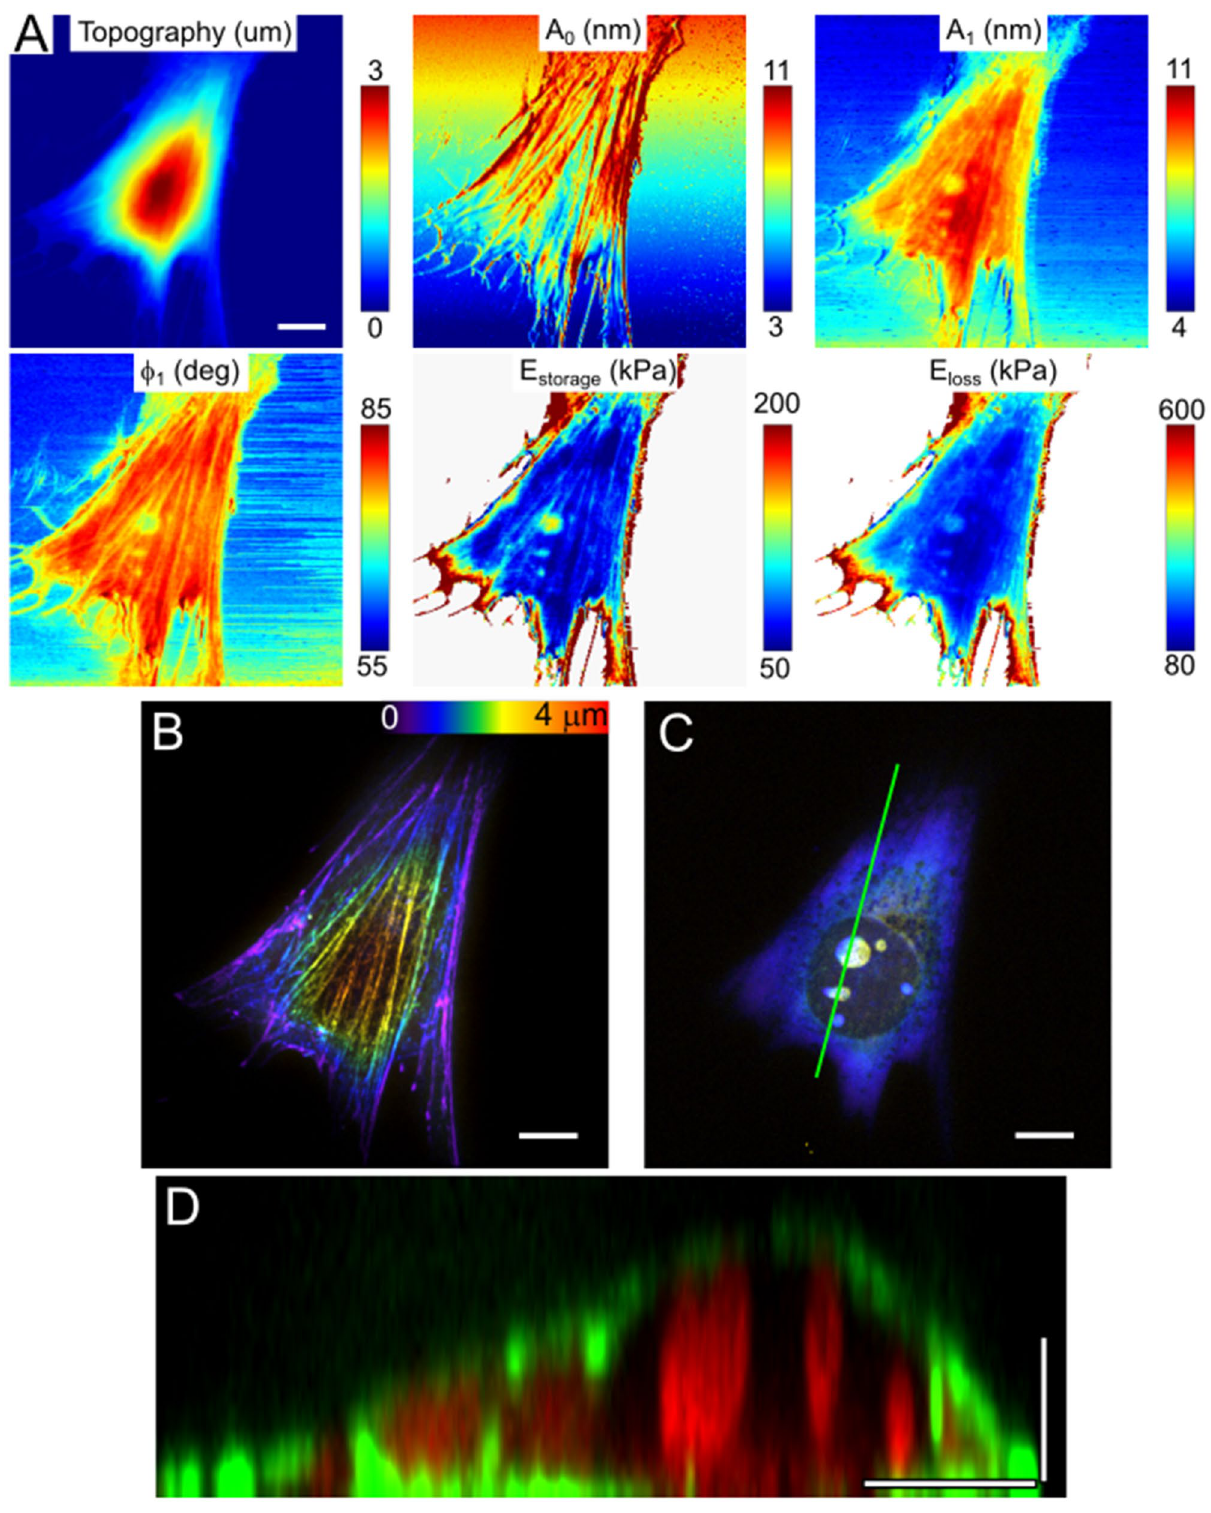
Figure 3. The NIH 3T3 fibroblast, AFM observables and nanomechanical maps. ( A ) and SDCM color-coded height images ( B , C ). Both perinuclear actin cap fibers and nucleoli could be detected in the amplitude and phase images, and in the E storage map. Only the actin fibers, but not nucleoli, are presented in topography and deflection images. ( B , C ) Corresponding images of the F-actin cytoskeleton (SiR-actin staining, B ) and nucleoli (SYTO85 staining, C ), color-coded Z-stacks. ( D ) Vertical cross-section along the marked line shows the size and depth of the nucleoli (red) and cell shape (F-actin, green). Scale bars are 10 μm in the horizontal direction and 2 μm in the vertical